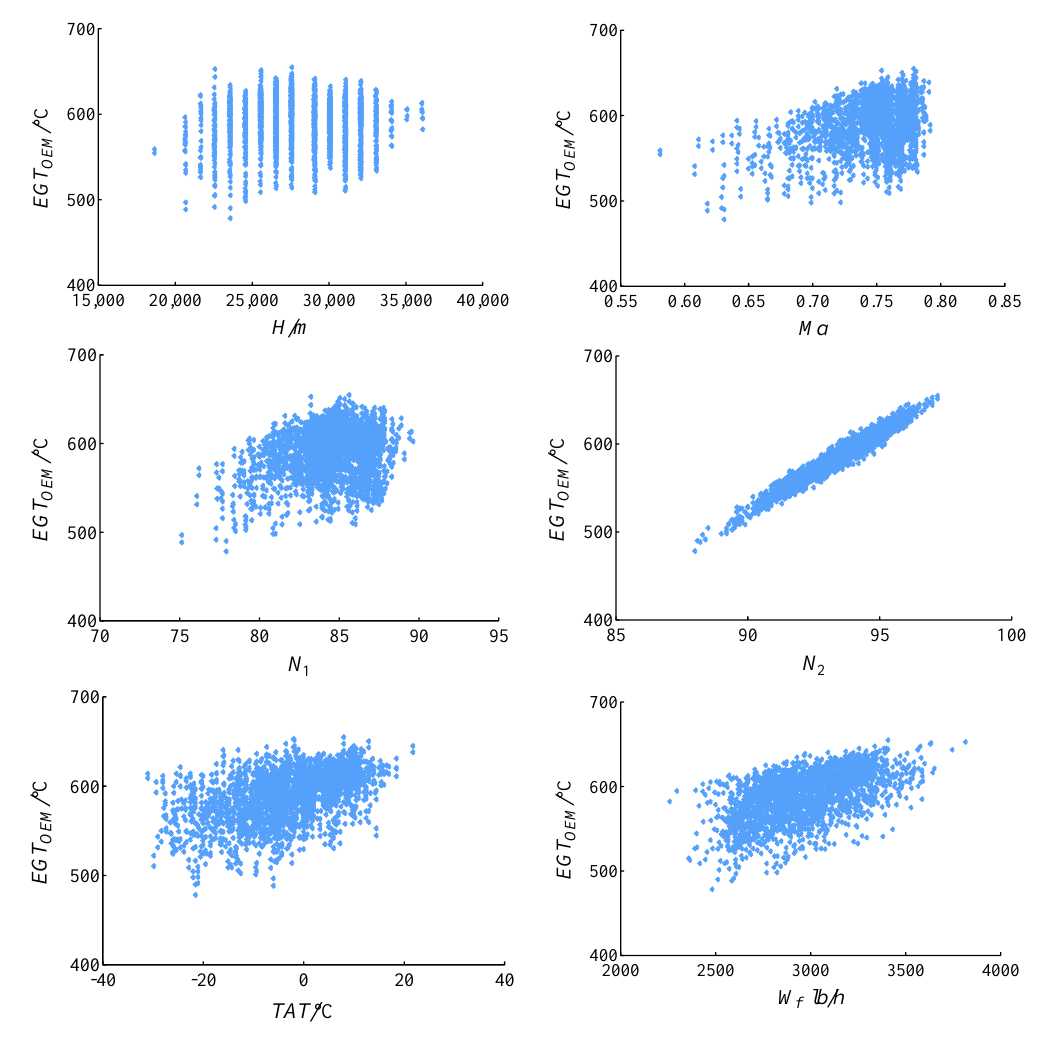
Figure 6. The scatter plot of six parameter variables.